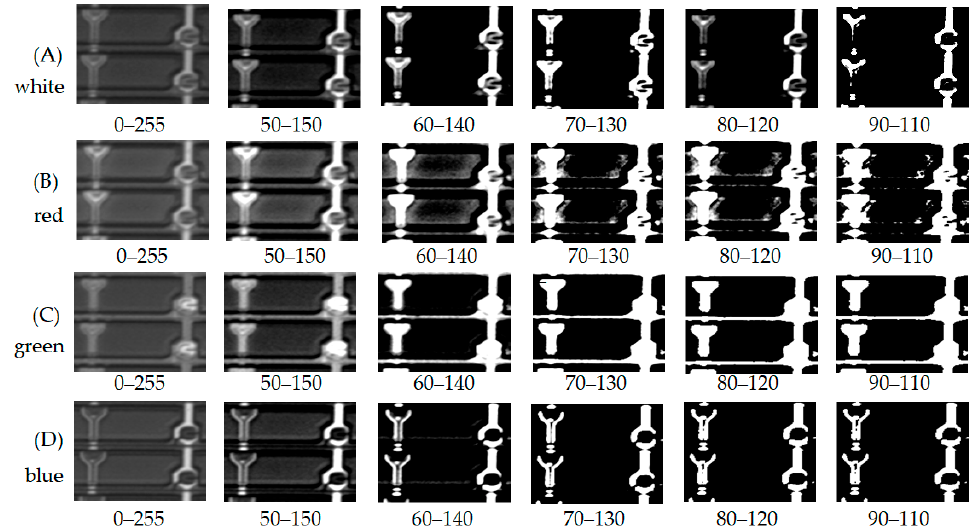
Figure 5. Recognition of the via-hole passivation on the fourth layer using white, red, green, and blue LED detection concerning rows ( A – D ) with the various gray distribution concerning ( A ) white light, ( B ) red light, ( C ) green light, and ( D ) blue light. Table 1. The parameter of working distance in the optical evaluation.